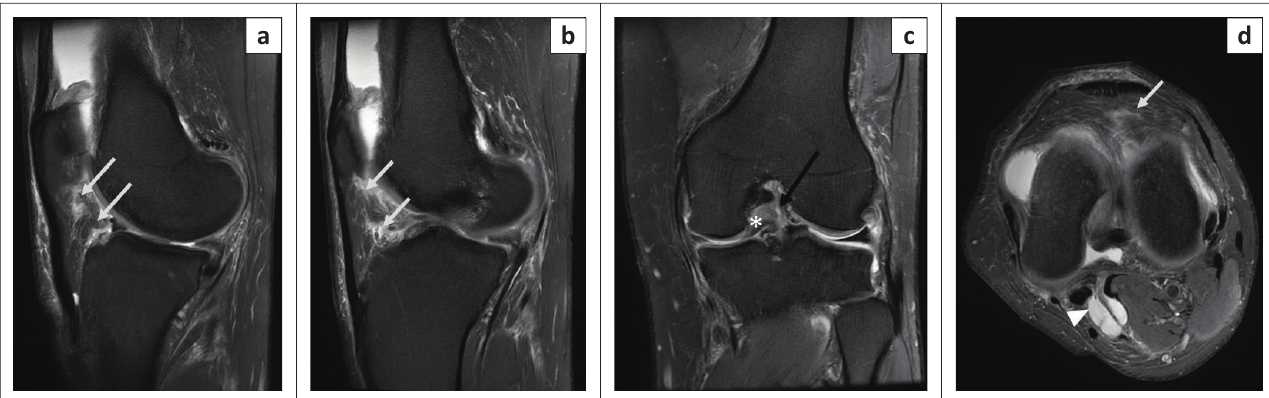
FIG URE 5: Magnetic resonance imaging of infrapatellar plica sprain in a 45-year-old male with a history of a fall: serial PDFS oblique sagittal images (a and b), oblique coronal PDFS (c) and axial PDFS (d) demonstrates hyperintense signal along the entire course of infrapatellar plica (white arrows in a, b and d) having ragged margins, with oedema in the surrounding Hoffa’s fat pad and oedema in the prepatellar subcutaneous plane (d). Note mild sprain in the middle third of the postero-lateral bundle of the anterior cruciate ligament in (c) (black arrow), associated bucket handle tear of the medial meniscus with the displaced fragment lying within the inter-condylar notch (c) (asterisk), small Baker’s cyst posteriorly (d) (arrow head).